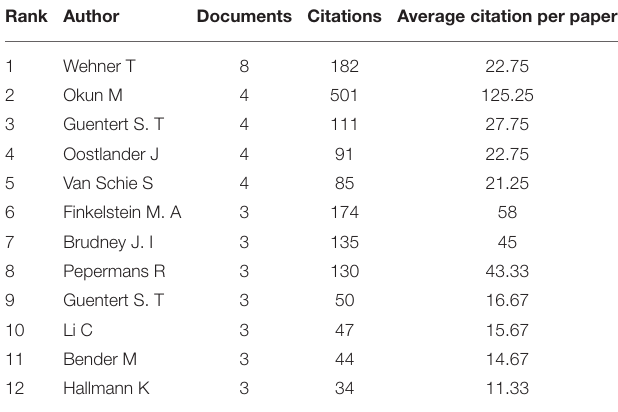
TABLE 5 | Most important authors in the volunteer motivation research field.